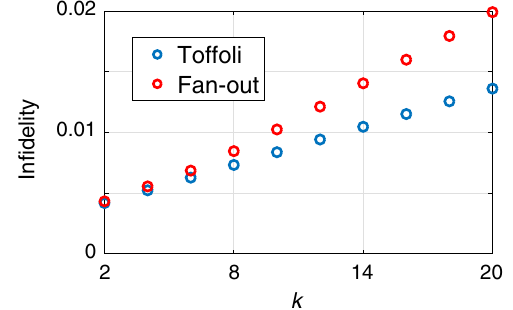
FIG. 10. Infidelity of the adiabatic superconducting multiqubit gate as a function of the number of qubits k . The fidelities of the two gates are evaluated for the parameters of row 2 in Table III, the damping rate γ = 2 π ¼ 5 . 7 kHz, and the driving strengths, Ω = 2 π ¼ 48 (160) MHz, Ω = 2 B 1 = 4 (1.0) for the Toffoli c t 1 ¼ (fan-out)